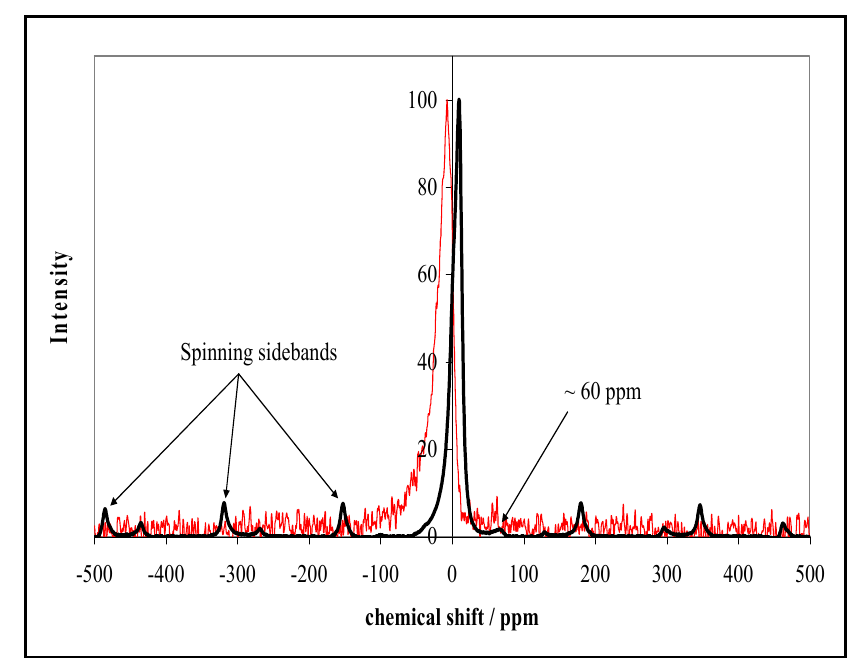
Figure 3. 27 Al MAS n.m.r. spectra of TiO /alumina prepared with 1 wt% alumina (red) and 2 25 wt% alumina (black) on rutile (series 2A). Sensitivities have been adjusted to facilitate comparison of the two